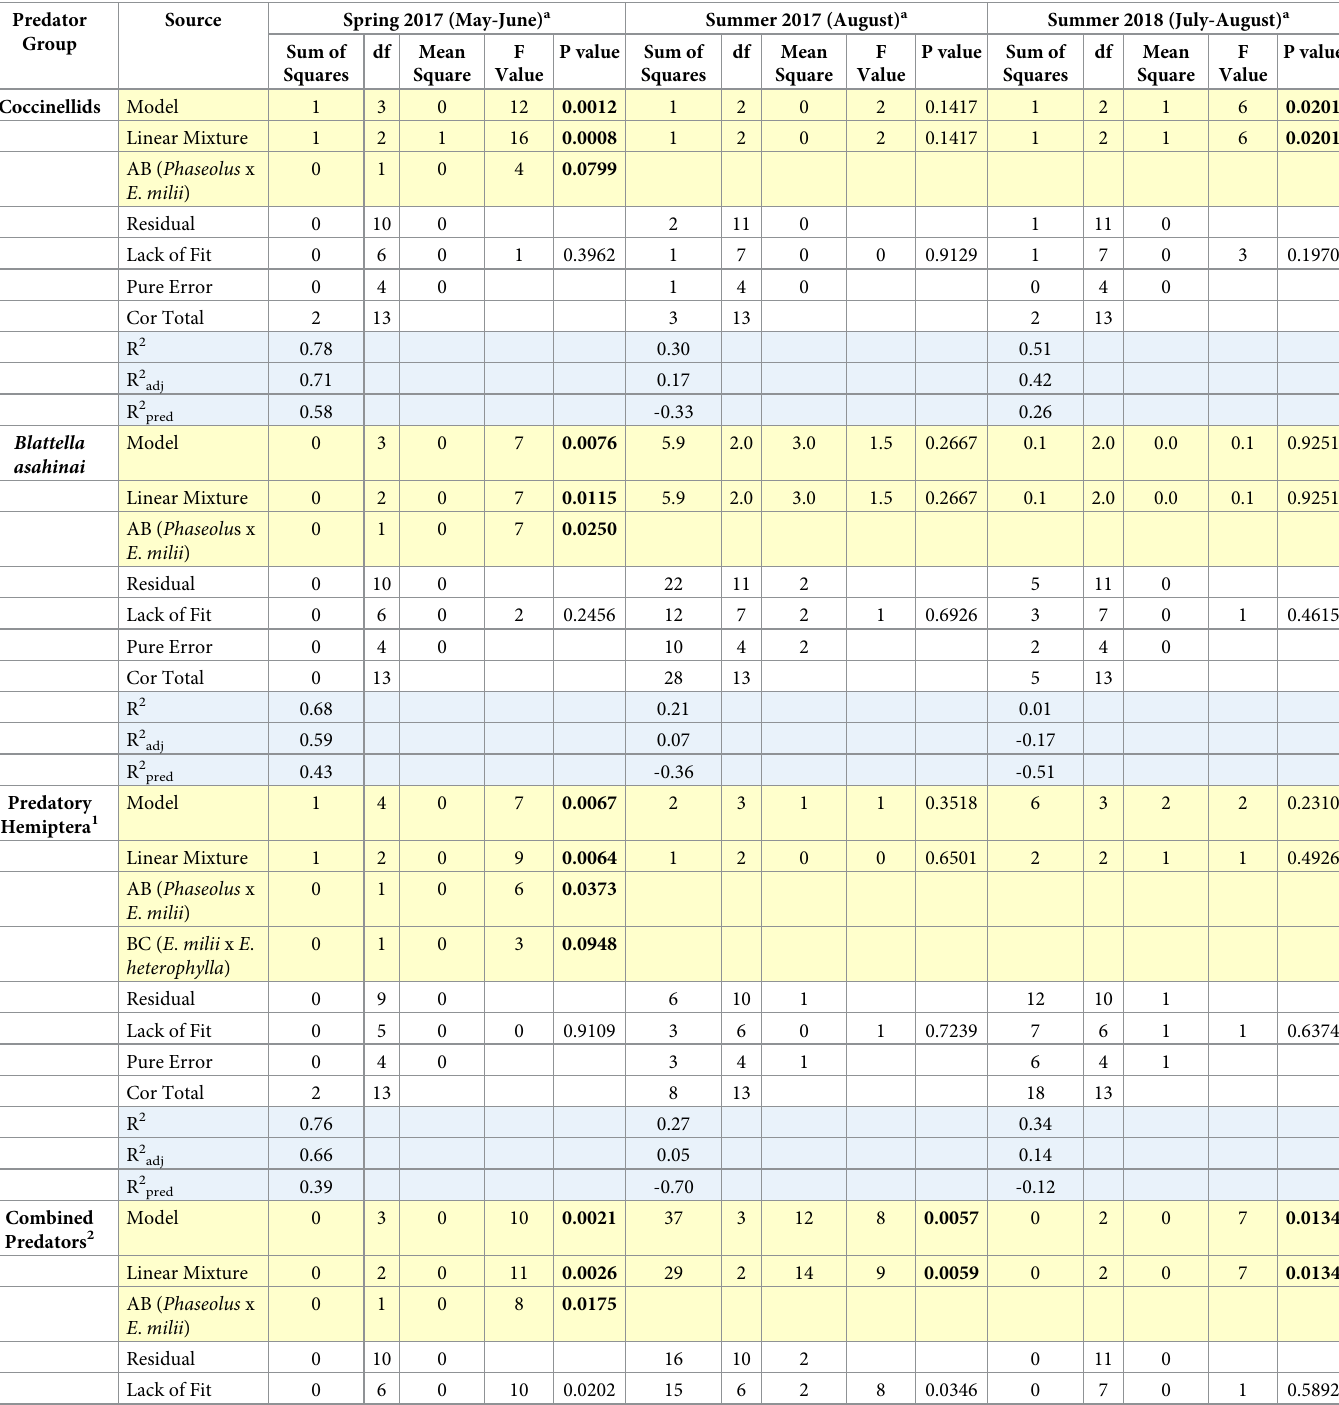
Table 6. Reduced quadratic response surface model, including diagnostic statistics, for natural enemy occurrence in response to mixture arrays containing three plant species. Note that the “linear model” term is used in a mixture ANOVA because the individual components are not independent and are considered together (com- pared to each other). The effect of a mixture component is defined by a gradient (or slope) in some specified direction, and these effects are shown in the trace plots (Figs 4 & 5). The terms AB, AC, and BC are quadratic blending or nonlinear blending terms in mixture models and show if the two components are exhibiting a synergism or antagonism–i.e., a response not predicted by the simple additive blending in the linear mixture model. They are not “interaction” terms because the components are not